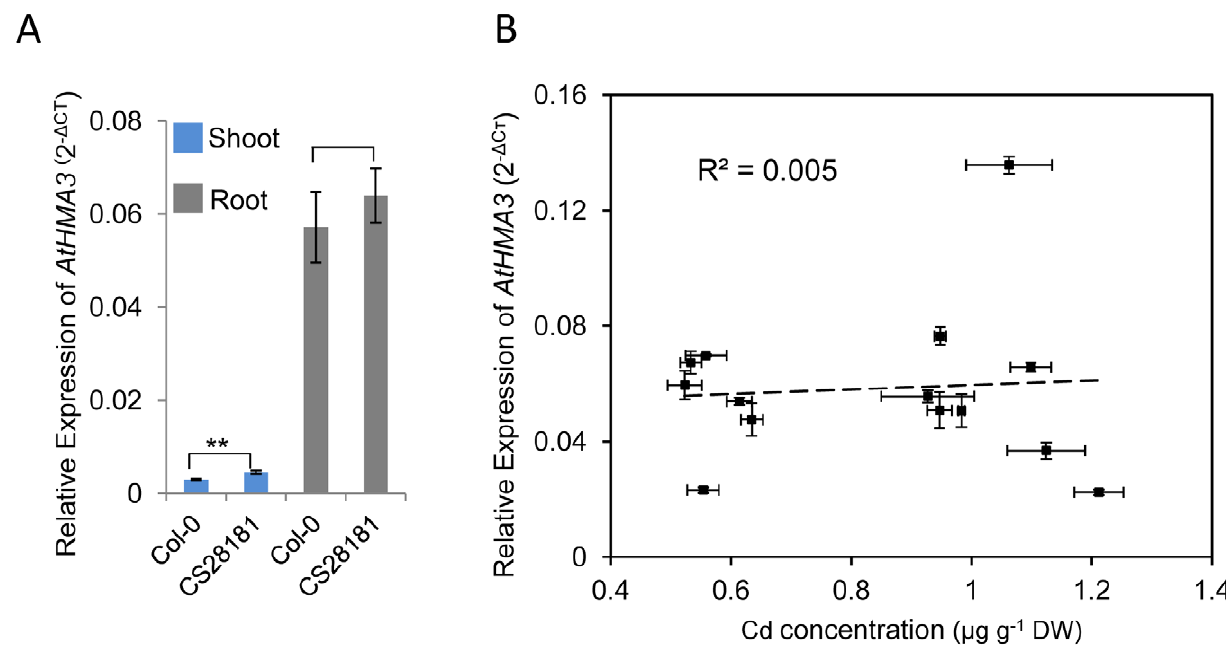
Figure 6. Quantification of expression of HMA3 in various A.thaliana accessions by quantitative real-time RT–PCR. A. Expression of HMA3 in shoot and root of A. thaliana accession Col-0 and CS28181. B. Correlation between root expression of HMA3 and leaf Cd accumulation in 14 A. thaliana accessions. For the analysis UBC ( AT5G25760 ) was used as an internal normalization standard across all samples. The expression of HMA3 was calculated as 2 2 D CT relative to UBC . Data represent means 6 standard error (n=4 independent biological replicates per accession and tissue).